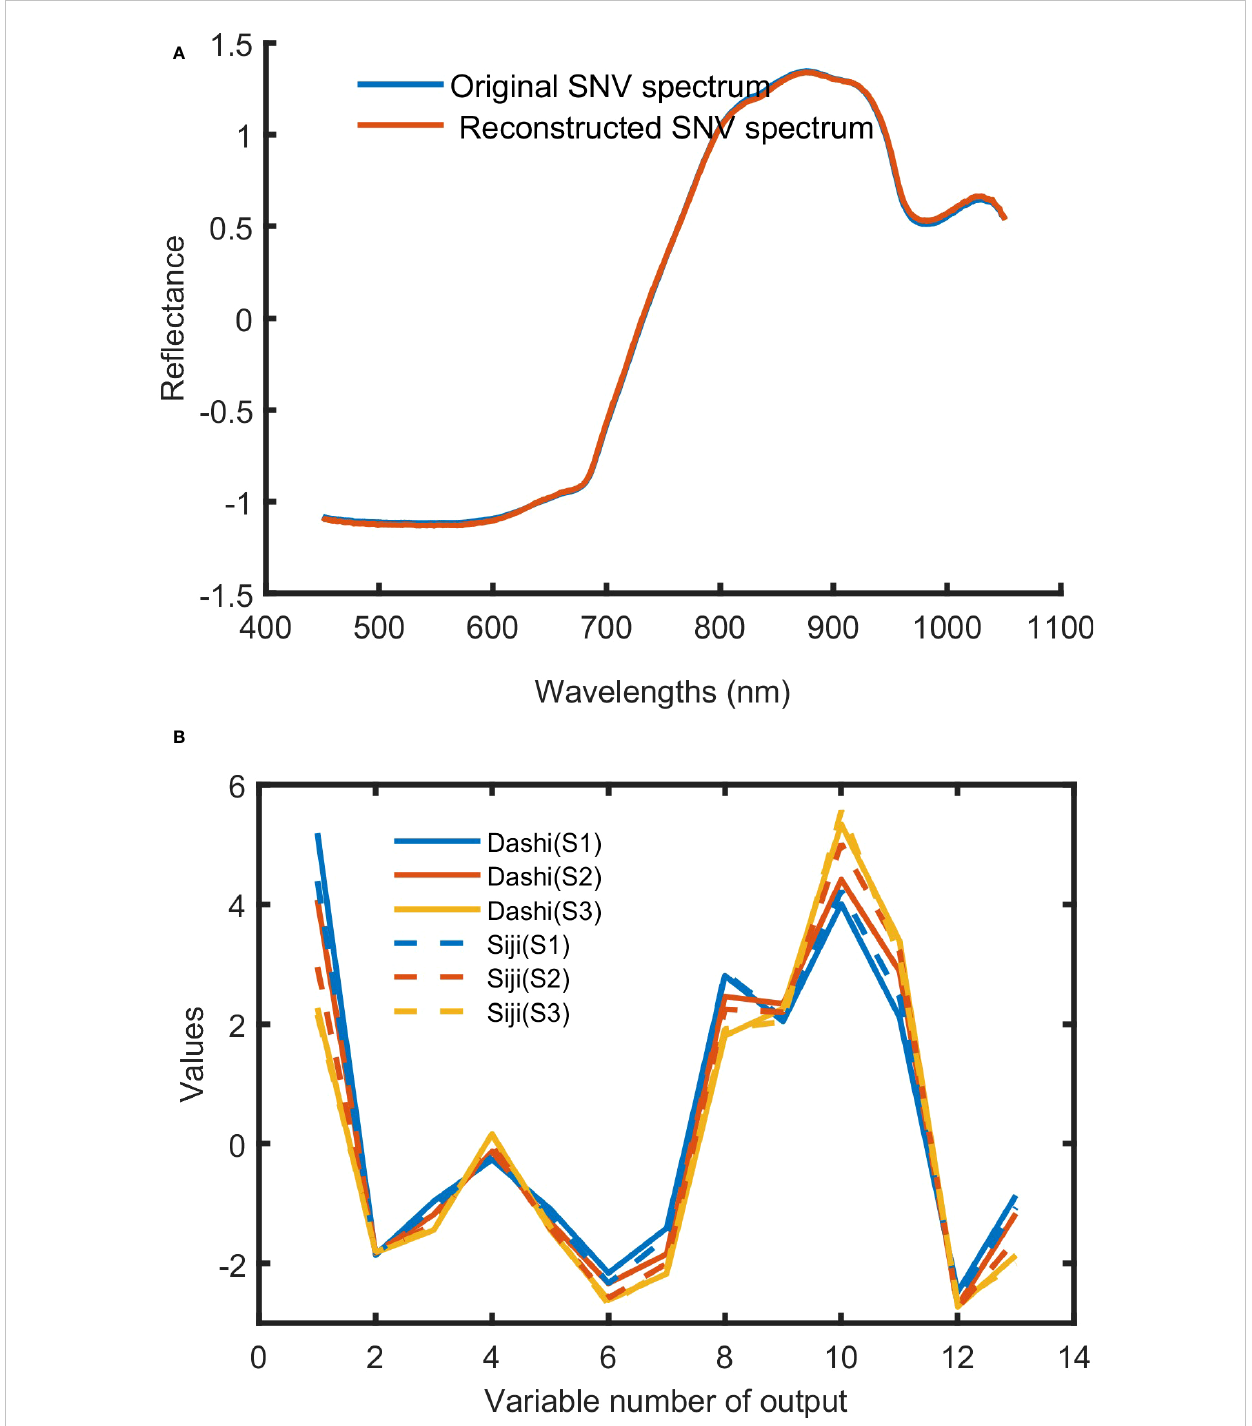
FIGURE 7 The training results of SAE. (A) Original SNV spectrum and reconstructed SNV spectrum; (B) deep spectral features of Dashi and